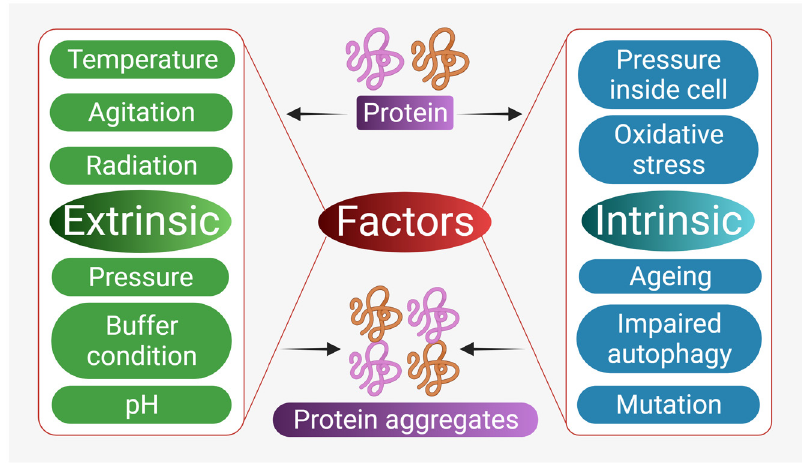
Figure 1: Factors affecting protein